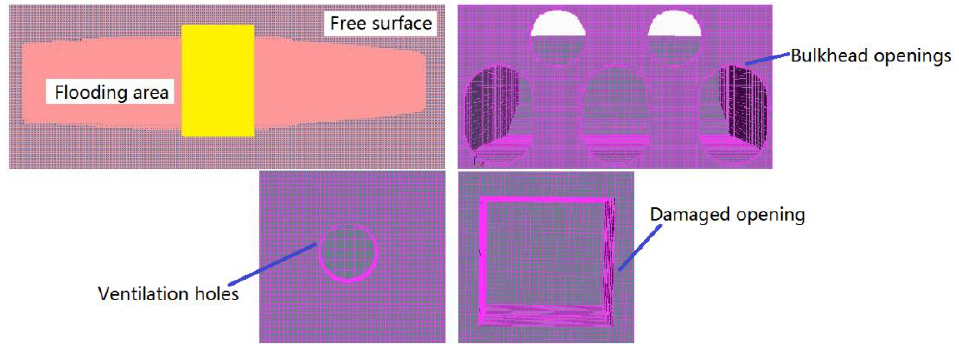
Figure 8. Local mesh refinement.